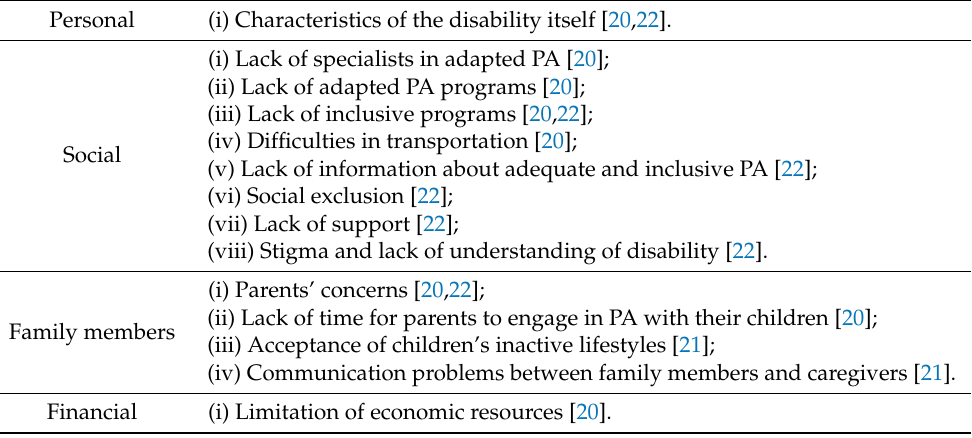
Table 4. Barriers to PA practice in the perception of family members.